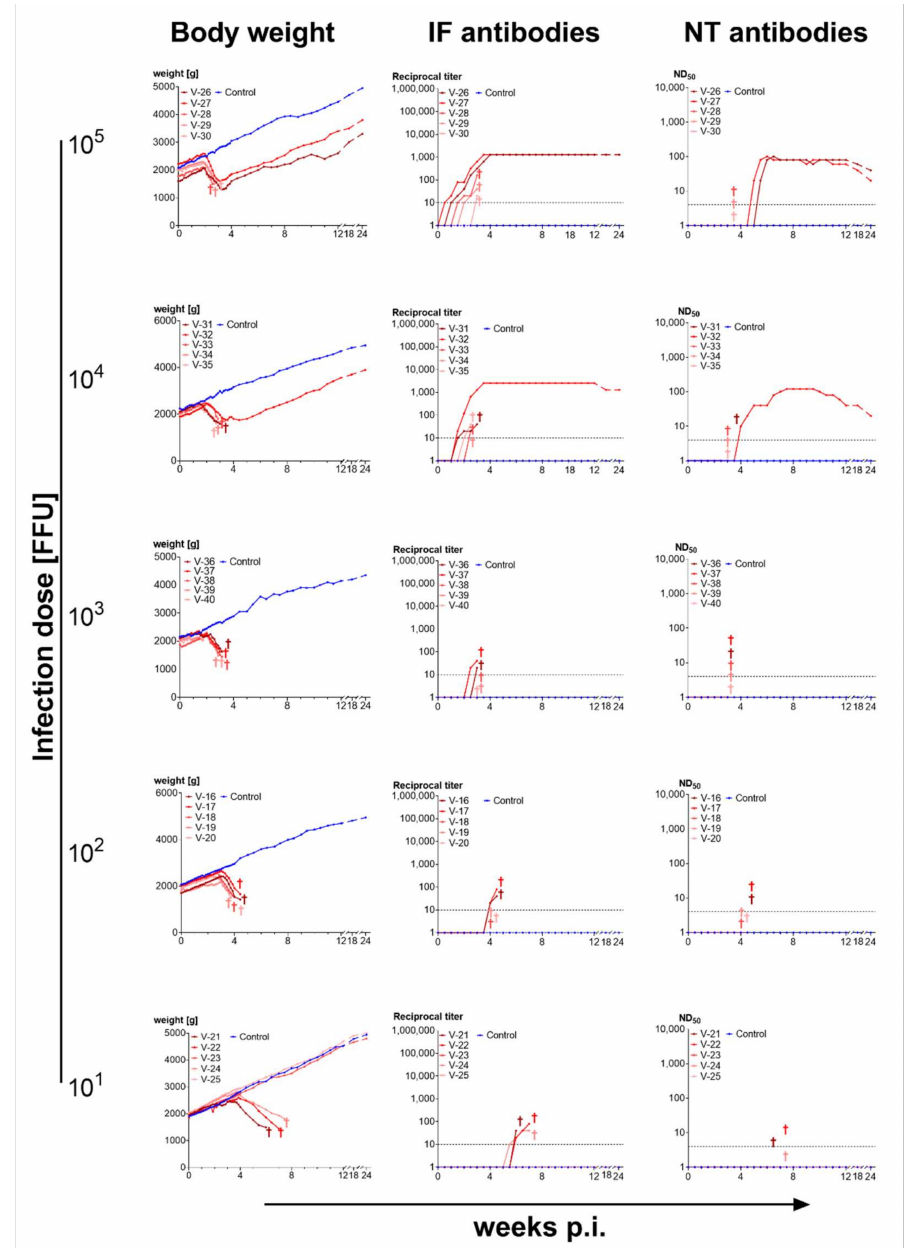
Figure 5. Titration of infectious dose of brain-derived BoDV-1 (strain V/B) in rabbits. Shown are the kinetics of body weight changes, immunofluorescent (IF) antibody titers and neutralizing (NT) antibody titers following infection challenge with 10 5 FFU brain-derived BoDV-1, 10 4 FFU brain-derived BoDV-1, 10 3 brain-derived BoDV-1, 10 2 FFU brain-derived BoDV-1, and 10 1 FFU brain-derived BoDV-1. Dashed lines, IF and NT assay limits of detection; †, animal euthanized before succumbing to lethal